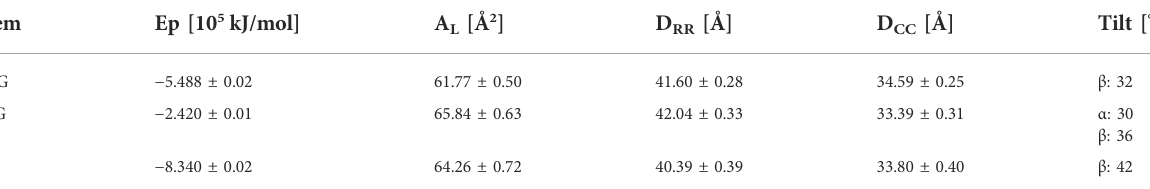
TABLE 1 Mean values of the simulated systems parameters.